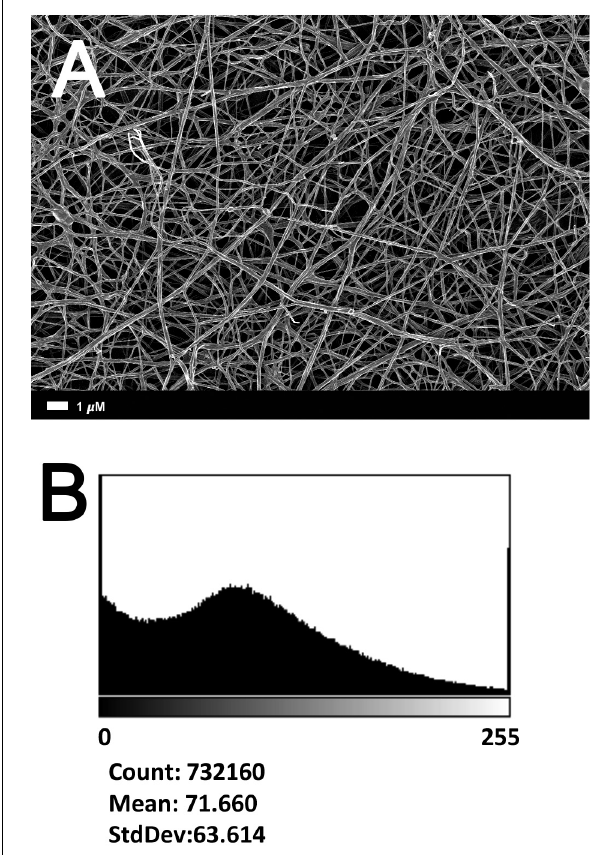
FIGURE 2 | (A) Clot structure from a representative healthy individual as seen with SEM. All clots were created by adding thrombin to PPP (prepared after whole blood is centrifuged for 15 min at 3,000 g ). (B) Representative histogram of the 8-bit intensity for the SEM clot shown in (A)